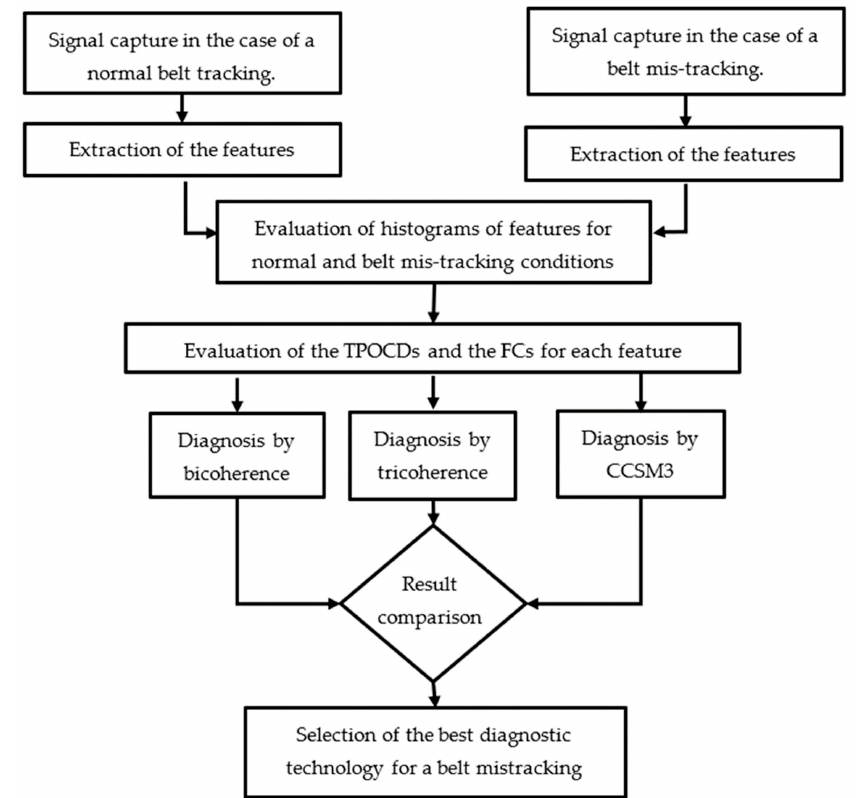
Figure 1. Flow chart of the adopted research method.